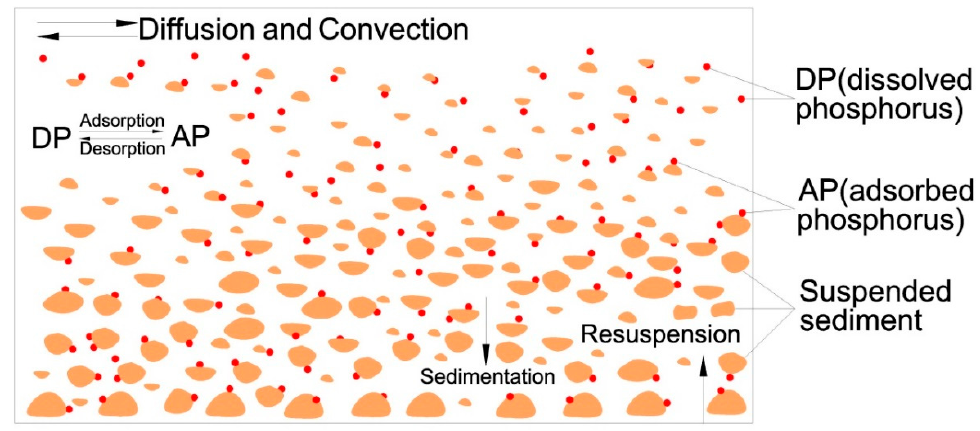
Figure 3. Conceptual model of the phosphorus transport (the red circles represent dissolved or adsorbed phosphorus, the irregular khaki circles represent suspended sediment particles).